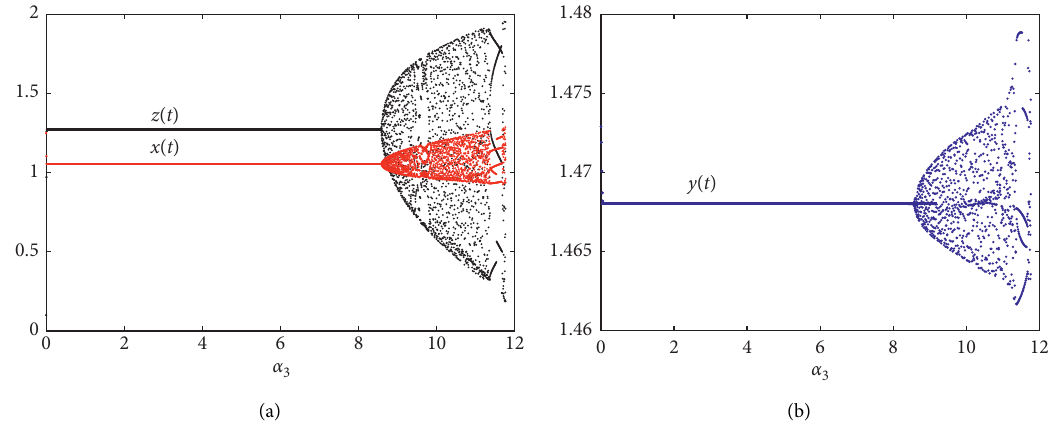
Figure 5: Bifurcation diagram for α